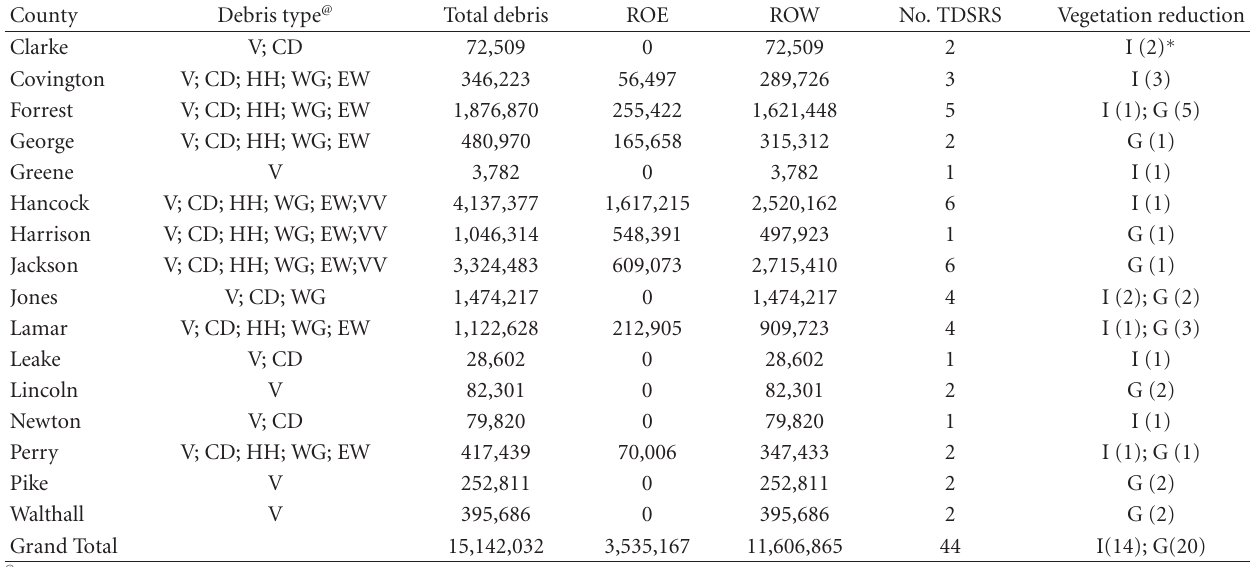
Table 1: Debris (m 3 ) removed from ROE and/or ROW in 16 Mississippi counties.